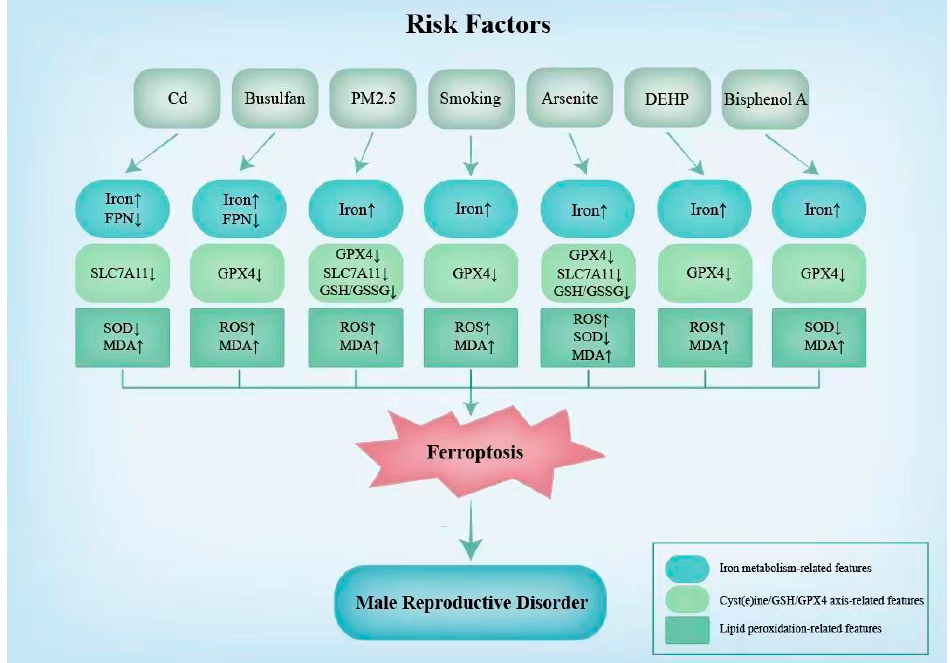
Figure 3. Ferroptosis-related features in male reproduction induced by risk factors. The changes in biochemical indicators and levels of the expression of ferroptotic genes caused by the risk factors associated with ferroptosis are listed in this figure. Cd, cadmium; DEHP, di-(2-ethylhexyl) phthalate; FPN, ferroportin; SLC7A11, catalytic subunit xCT/Solute Carrier Family 7 Member 11; GPX4, glutathione peroxidase 4; GSH, glutathione; SOD, superoxide 2-ethylhexyl smutase; MDA, malondialdehyde; ROS, reactive oxygen species.